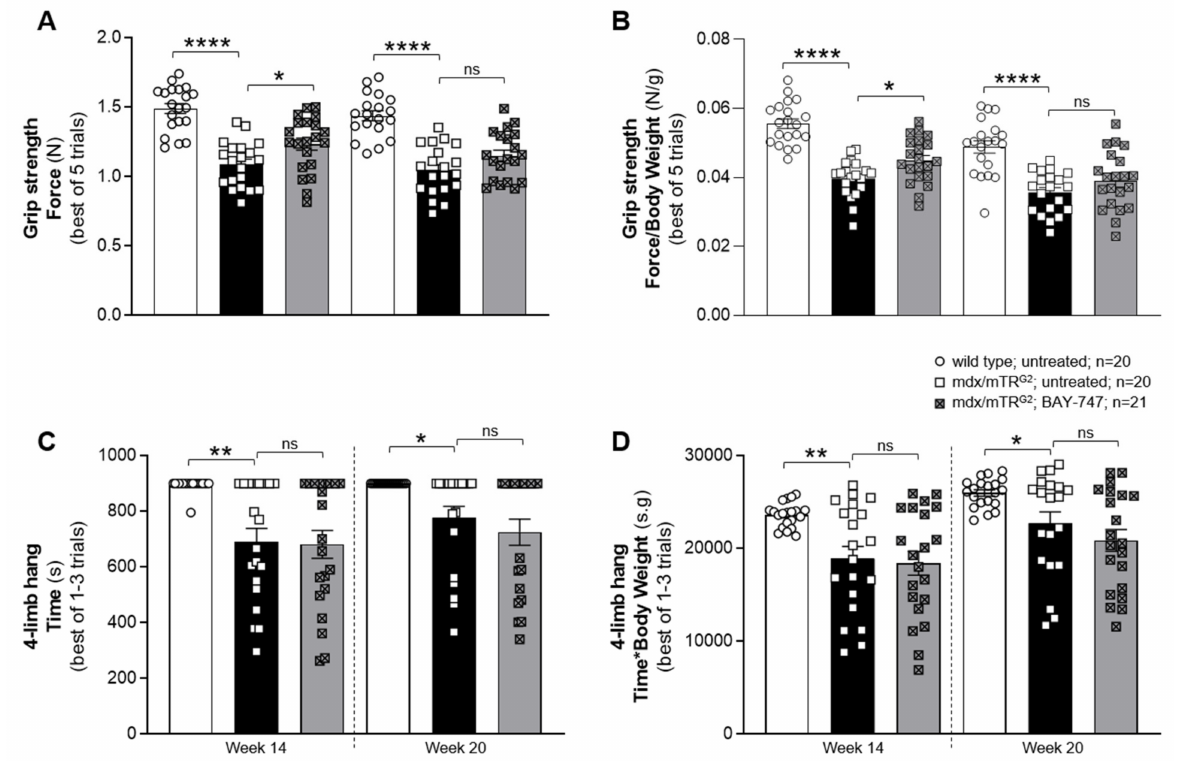
Figure 3. BAY-747 treatment improved forelimb grip strength but not the four-limb hang capacity in mdx/mTR G2 mice. Treatment with BAY-747 improves forelimb grip strength capacity ( A , B ) but does not improve four-limb hang capacity ( C , D ) of mdx/mTR G2 mice compared to untreated mdx/mTR G2 mice at the interim time point (Week 14) but not to a significant level at the final time point assessed (Week 20). * p < 0.05; ** p < 0.01; **** p < 0.0001; ns, not significant for one-way ANOVA followed by Dunnett’s multiple comparison post-hoc